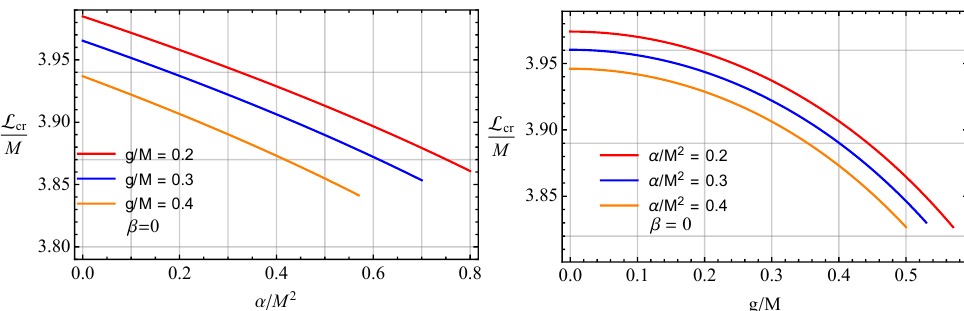
Figure 11. Figures show the dependence of the critical value of angular momentum to the α .